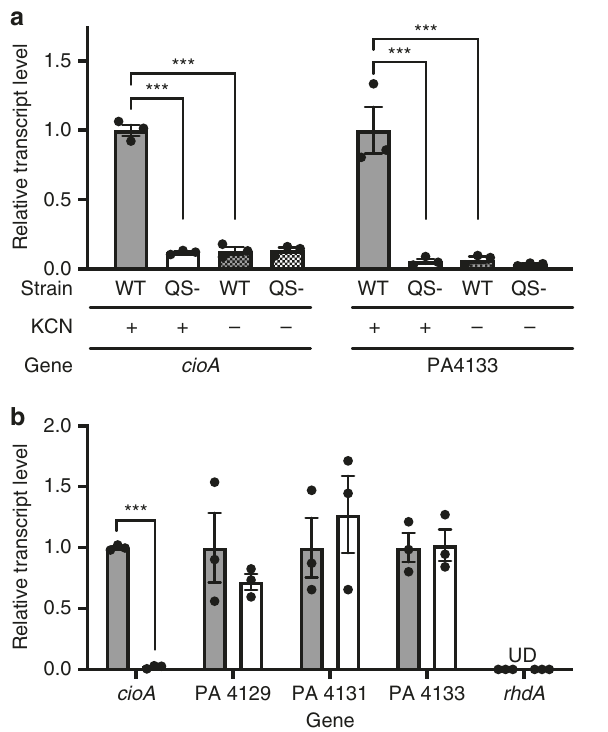
Fig. 2 Regulation of cioA (PA3930) by QS is conditional on the presence of cyanide. a Expression of cioA (PA3930) and PA4133 in the WT PAO1 (black, “ WT ” ) and LasR-RhlR-double mutant (white, “ QS- ” ). Solid, in the presence of 150 μ M KCN; grid, in the absence of 150 μ M KCN. b cioA , PA4129, PA4131, PA4133, and rhdA expression from either WT PAO1 ( “ policing ” , black) or RhlR-null cooperators ( “ non-policing ” , white) when grown in co-culture with cheaters, with the populations separated by dialysis membranes. Expression was measured by RT-PCR with proC used as reference gene. Means, s.e.m., and individual biological replicates are shown ( n = 3). Statistical signi fi cance determined by unpaired Student ’ s